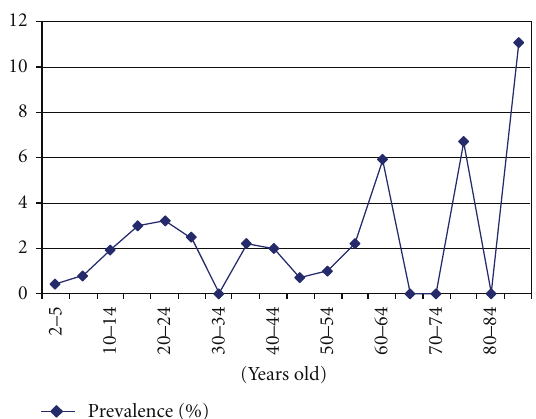
Figure 3: Age-specific prevalence of schistosomiasis in Luzon, 2007.